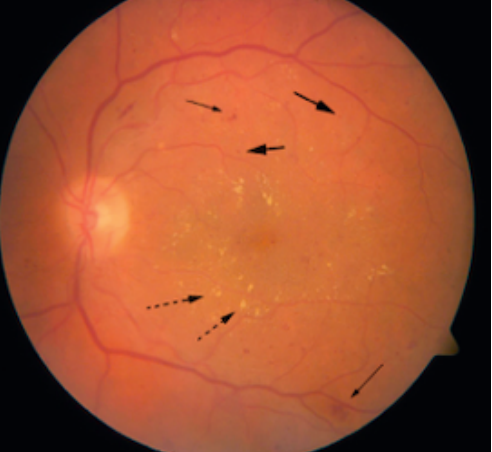
Figure 3. Retina with DME (Solid arrows: Microaneurysms, Dashed arrows: